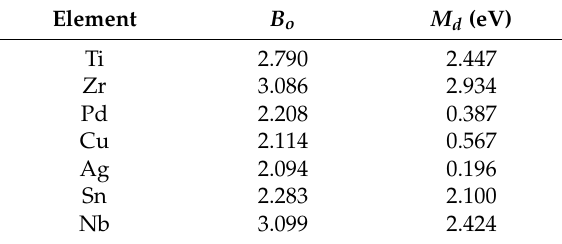
Table A1. B o and M d values for alloying elements in bcc Ti